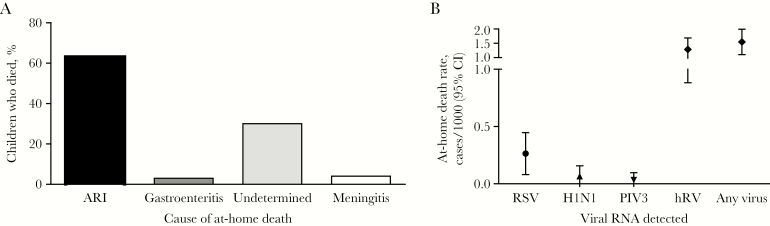
Distribution of the causes of at-home mortality determined by verbal autopsy (VA; A) and quantitative polymerase chain reaction (qPCR) of respiratory tract secretions (B). VA revealed that acute respiratory infections were the most frequent diagnosis, occurring in 63 children who died. qPCR analysis revealed that, among secretions testing positive for human rhinovirus (hRV), syncytial virus (RSV), influenza A(H1N1) virus, or parainfluenza virus type 3 (PIV3) RNA, at-home death rates were highest for hRV. CI, confidence interval.